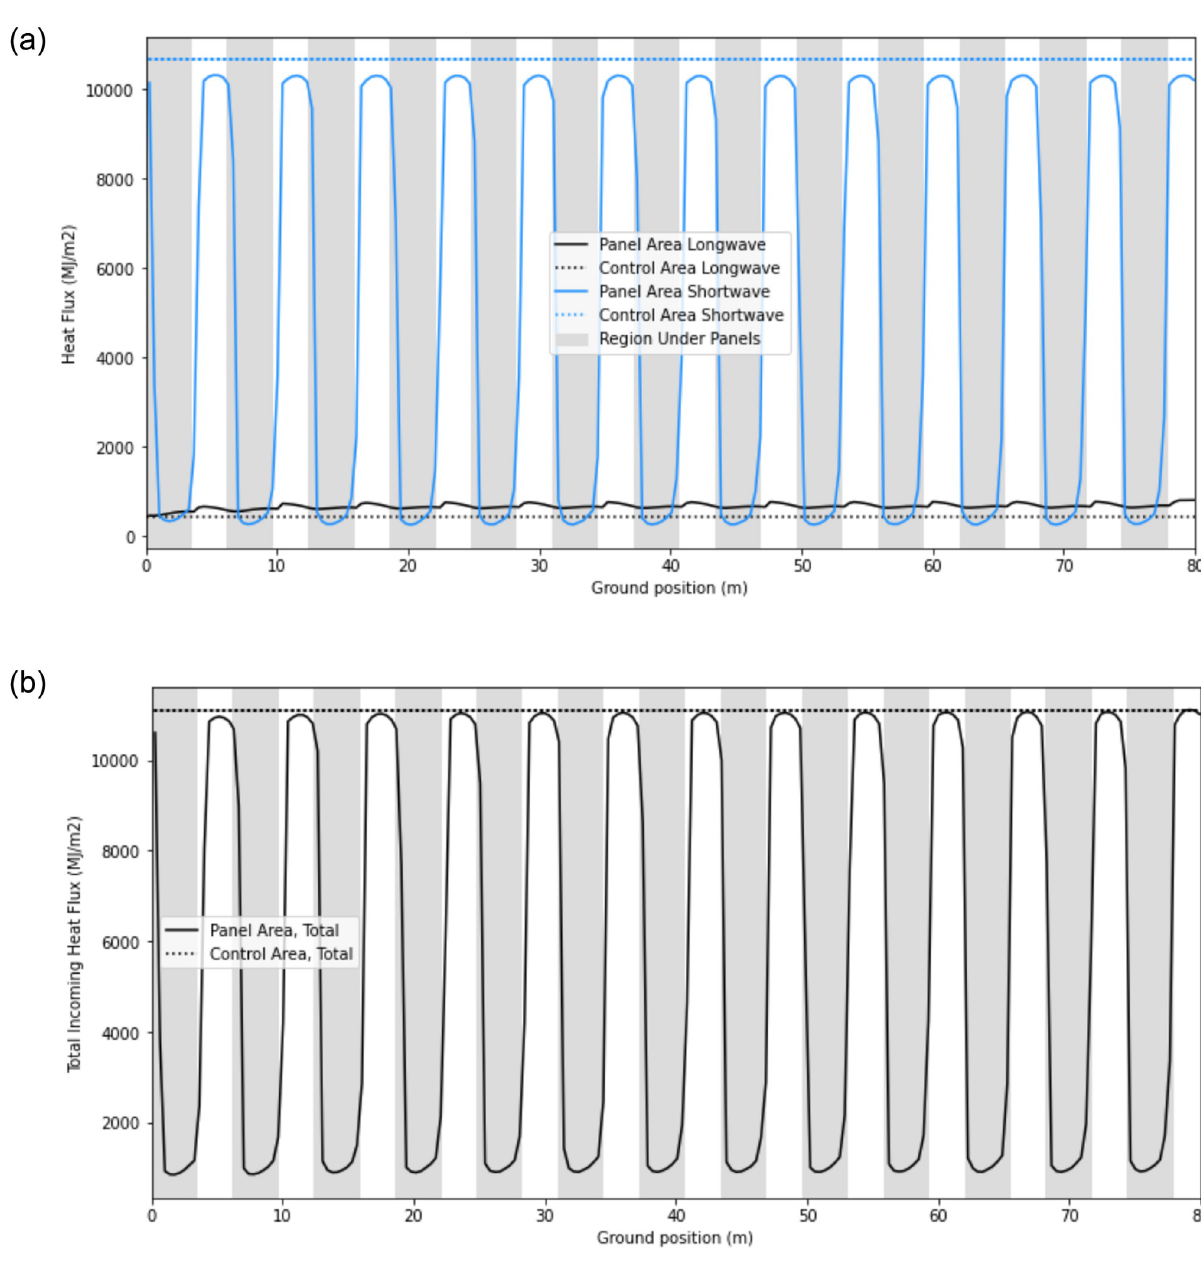
Fig 13. a. Longwave and shortwave radiation at ground under panels vs. full sun (control), accumulated over May 6 to May 22, 2015. b. Total incoming radiation at ground under panels vs. full sun (control), accumulated over May 6 to May 22, 2015.